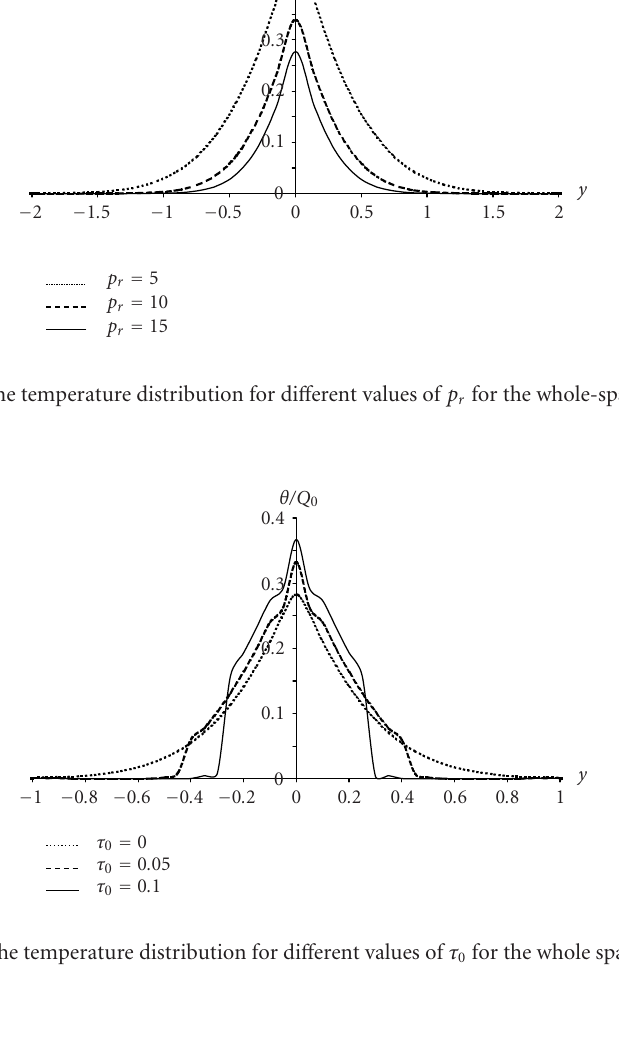
solutions obtained are utilized in combination with the method of images to obtain the solution for a semispace problem with a plane distribution of heat sources located inside the fluid. This enables us to represent the typical numerical results in figures for the temperature, velocity, and angular velocity for various values of the parameters. Hence we conclude with the following